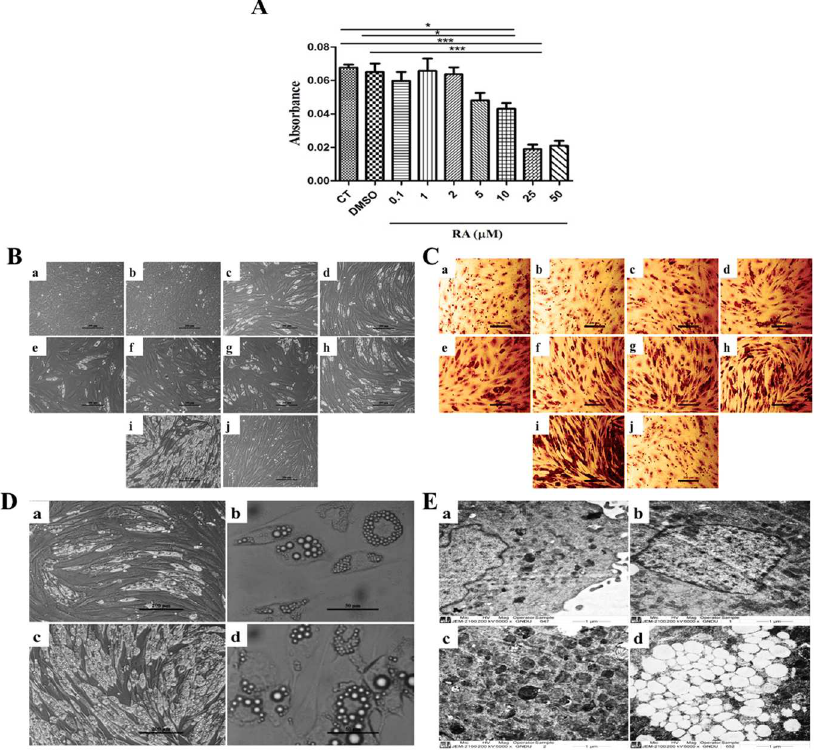
Fig 3. CPF augmented RA-induced differentiation of C 3 H 10 T ½ cells to adipocytic lineage. (A) MTT assay shows cell viabilityretainedby RA at concentrations rangingfrom 0.1–2 μ M. Higher concentrations were found to be toxic. Hence, RA at concentration of 2 μ M was used in all the subsequent experiments. Plotted values representmean ± SEM (n = 3) and One-way ANOVA with Newman-Keuls Multiple Comparison Test performed for statistical analysis( * p < 0.001). (B) Phase-contrast micrographs indicatedappearanceof lipid vesicles (white) in (c) RA in comparisonto (a) CT, (b) DMSO and (j) CPF. Increasingconcentrations of CPF (0.01, 0.1, 1, 10, 25, 50 μ M) alongwith RA (2 μ M) resulted in enhancement of lipid vesicles (d-i). Scale- 200 μ m. (C) Oil Red O stainedcells followingabovetreatment. Scale- 50 μ m.These observations were further strengthened by (D) higher magnifications (a) RA (100x) (b) RA (400x) (c) RA+ CPF (100x) (d) RA+ CPF (400x). (E) 6000x transmission electron micrographs showingaugmentation of lipid vesicles in combined treatment of CPF and RA (d) but considerably less in presenceof RA alone(c). (a) CT and (b) CPF did not show appearance of any such lipid vesicles. Scale-